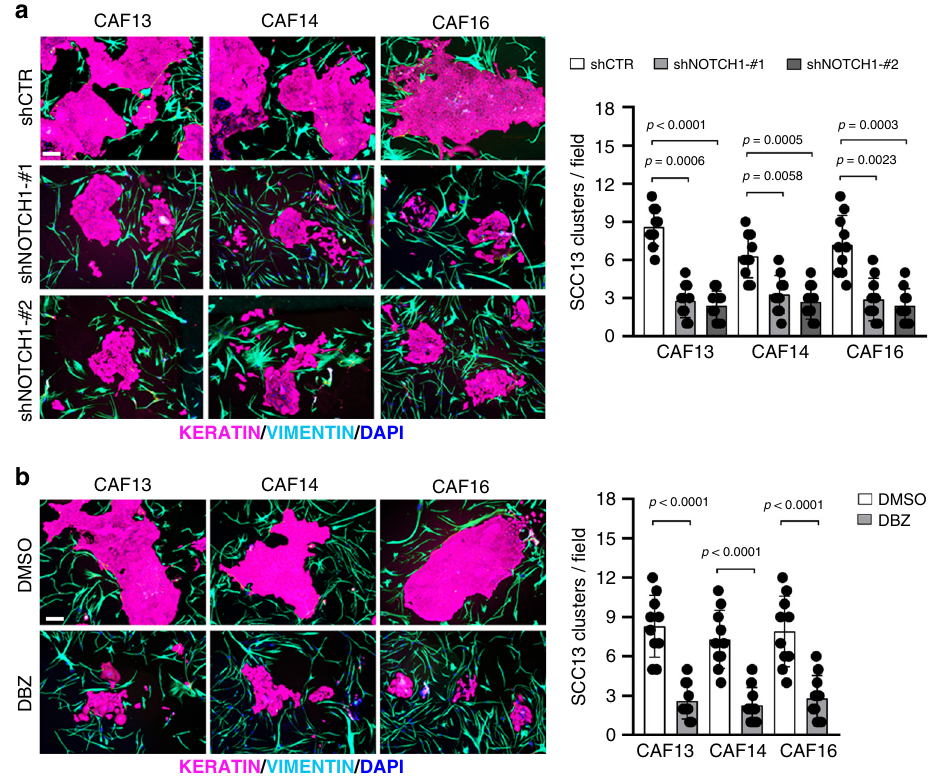
Fig. 8 NOTCH1 silencing or inhibition suppress CAFs-mediated proliferation potential of SCC13 cancer cells. a , b Representative images and relative quanti fi cation of immuno fl uorescence analysis with anti-PANKERATIN (magenta) and anti-VIMENTIN (cyan) antibodies of SCC13 cells co-cultured at a 1:1 ratio with CAF strains infected with a NOTCH1 silencing lentivirus versus empty vector control for 3 days ( a ) or treated with DBZ (10 µ M dose) versus DMSO for 3 days ( b ). Graphs show the quanti fi cation of large SCC13 cell clusters (>40 cells) per examined fi eld. Scale bar, 200 μ m. Values for each fi eld are indicated as dots with mean ± s.d. a One-way ANOVA with Dunnett ’ s test and b two-tailed unpaired t -test, ** p < 0.01, *** p < 0.001, **** p < 0.0001, n (CAF strain) = 3. n (number of fi elds, per sample) =